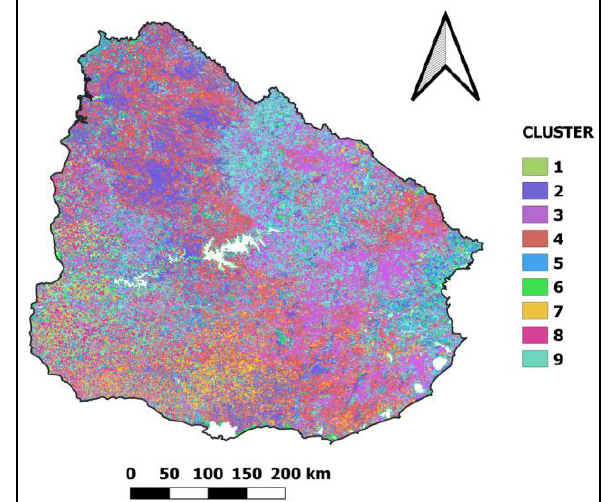
Figure 13. Map of clusters.